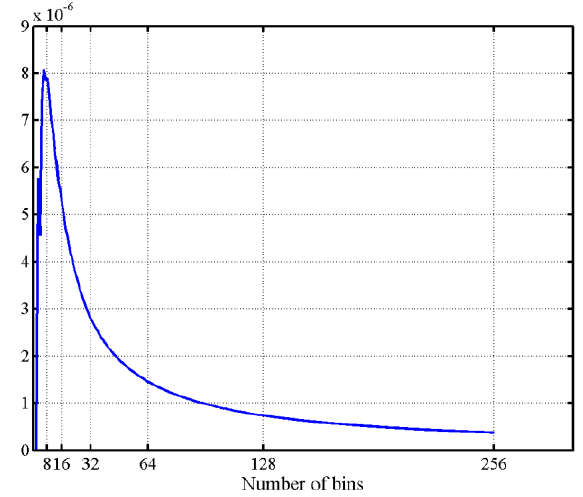
Figure 4. The derivation of similarity measure respect to transformation for 2-256 number of